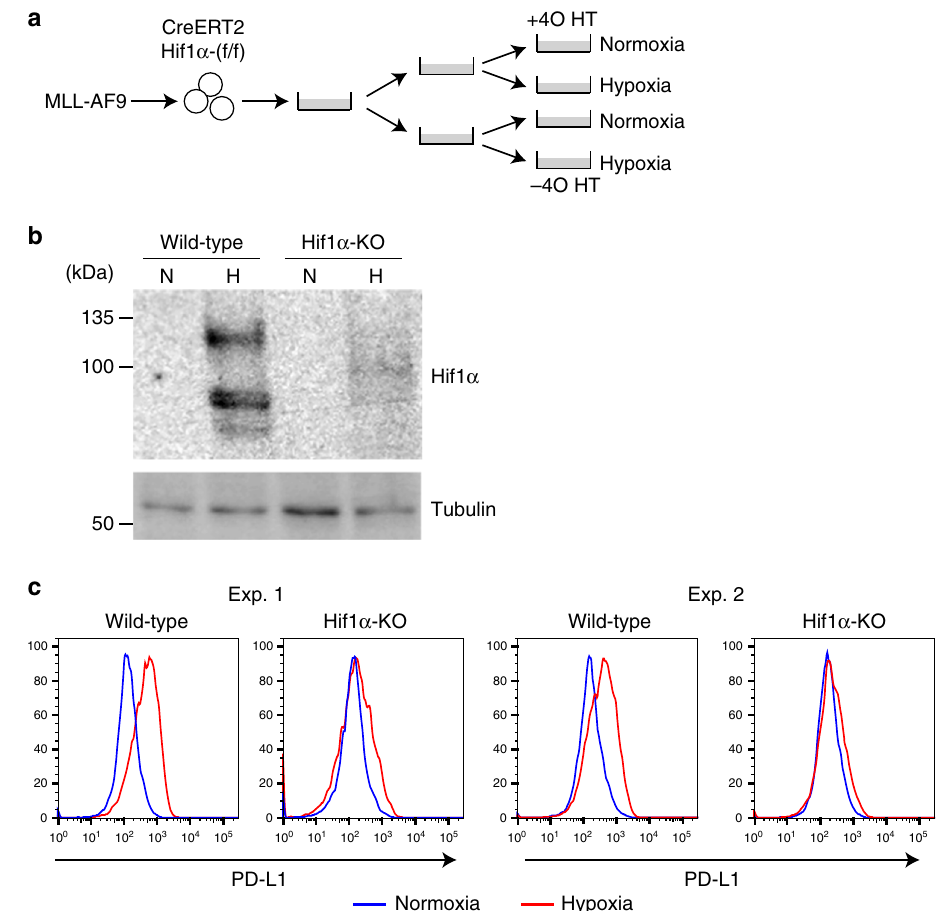
Fig. 4 PD-L1 is a downstream target of Hif1 α in MLL-AF9 cells. a Experimental scheme used in b , c . Bone marrow c-Kit + cells derived from Hif1 α fl ox/ fl ox ; Rosa26-Cre-ERT2 mice were transduced with MLL-AF9, and were treated with EtOH or 1 μ M 4OHT in semisolid media. The Hif1 α -intact and Hif1 α -deleted cells were then cultured under either hypoxia or normoxia condition for 24 h. b , c Cells described in a were subjected to immunoblotting with Hif1 α and tubulin antibodies ( b ), and FACS analyses to evaluate PD-L1 expression ( c